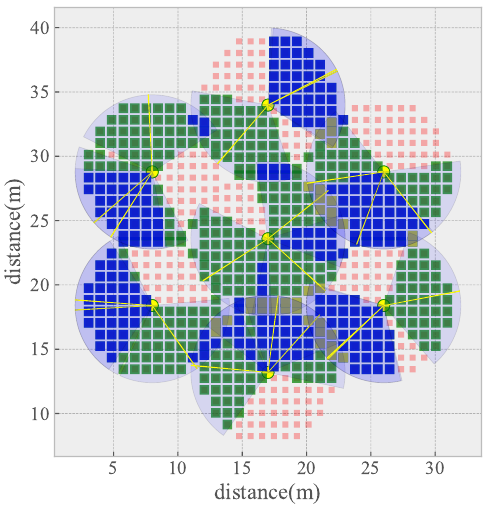
Figure 4. The initial coverage of an idea